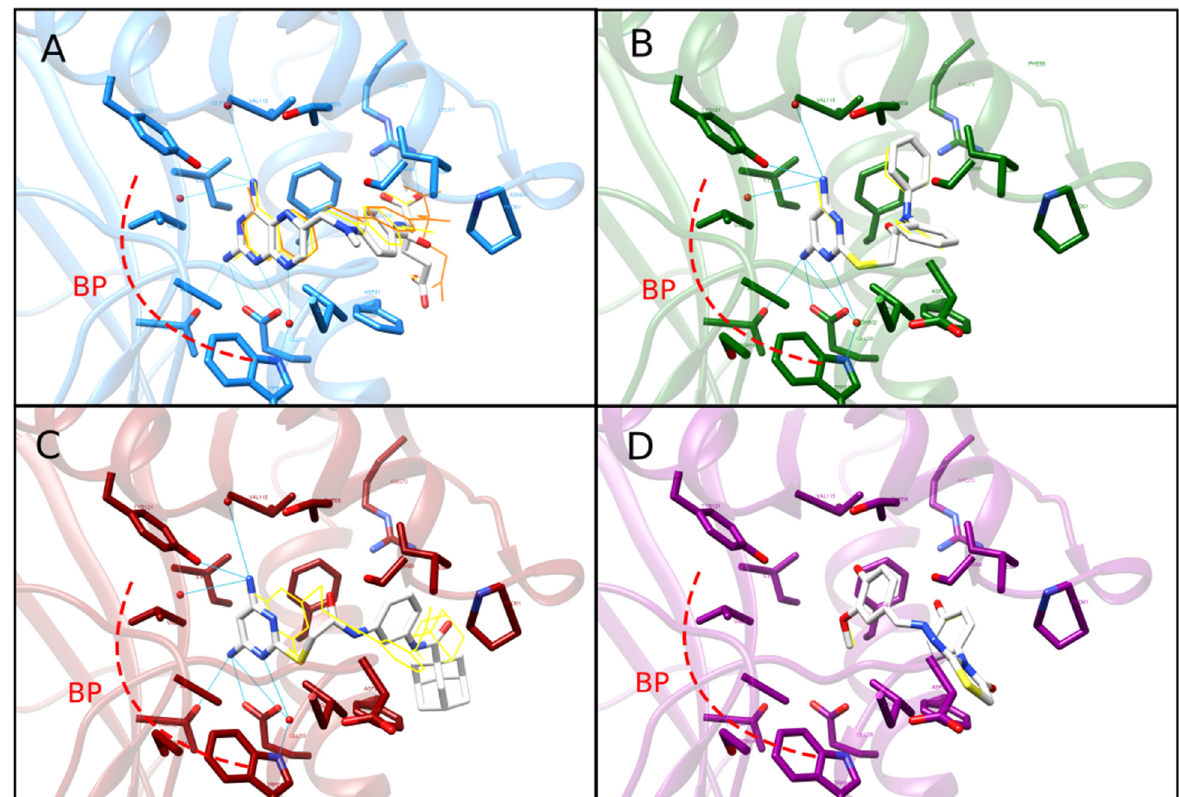
Figure 3. Predicted binding mode of compounds C1 and C2 on human DHFR active site. Superimposed 3D docked poses of the inhibitor MTX ( A ), hit compounds C1 ( B ) and C2 ( C ), and an hDHFR decoy ( D ) interacting with the hDHFR active site. In each case, ligands from initial docking are displayed in a yellow wire representation, and those from re-docking (i.e., including a structurally conserved water molecule) are shown as white sticks colored by heteroatom. The structure of hDHFR is represented as ribbons and the side chains of critical active site residues are shown as sticks colored by heteroatom. The original pose for MTX (PDB code: 1U72) is represented as an orange wire (see panel ( A )). H-bonds are shown only for re-docking poses and are displayed as blue continuous lines. The main binding pocket (BP site) of DHFR is illustrated in all panels as a red discontinuous curved line.